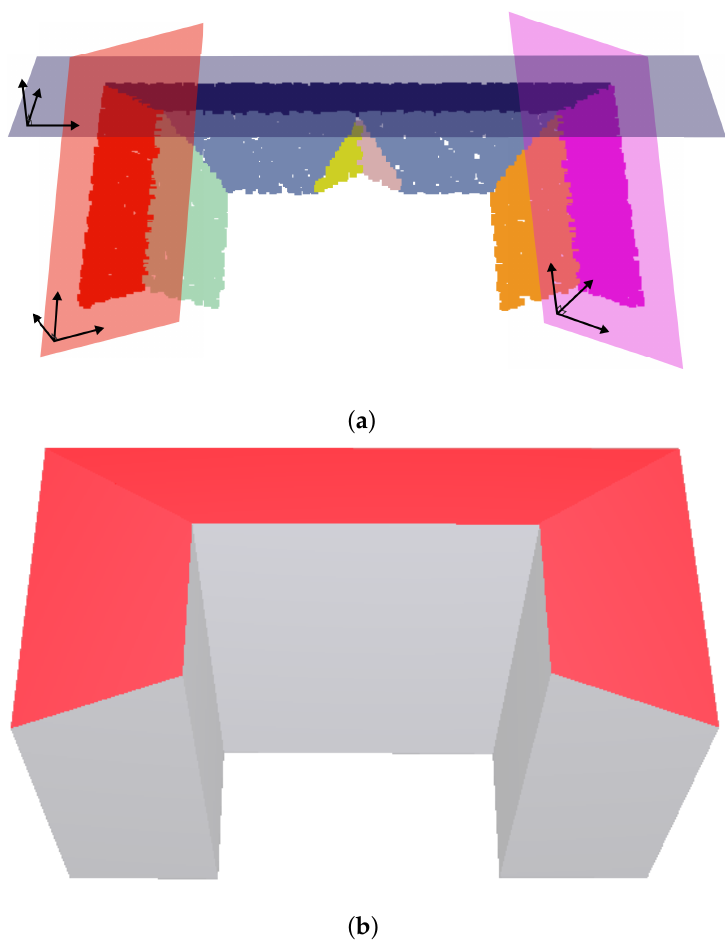
Figure 4. Illustration of shaping the building model with unobstructed half-spaces, where on the top ( a ) unobstructed half-spaces are shown, which are then subtracted from the base model ( b ) from Figure